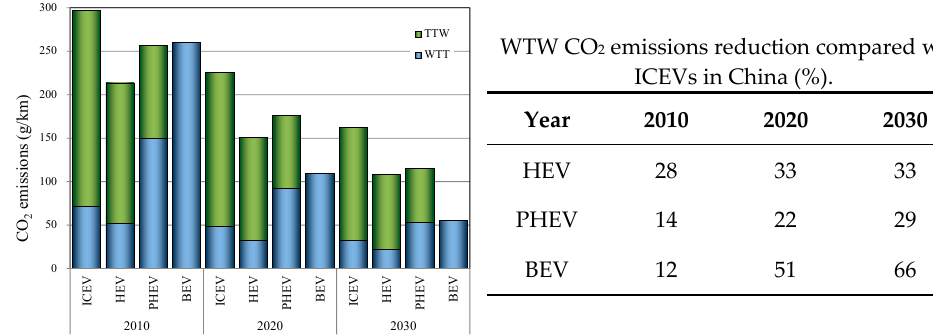
Figure 10. WTW CO 2 emissions of ICEVs/HEVs/PHEVs/BEVs in China.